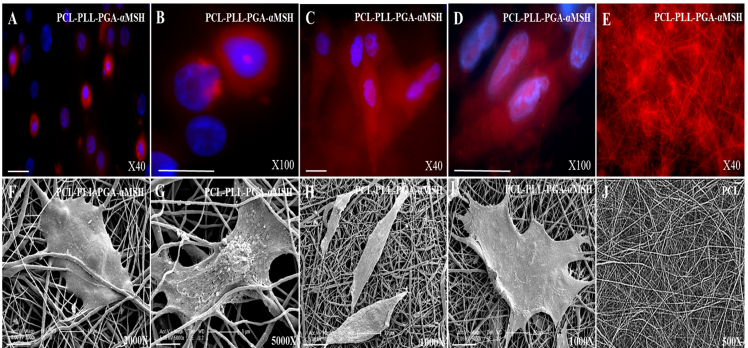
Figure 6. Immunofluorescent and Scanning Electron Micrograph (SEM). Analysis of oral epithelial cells ( A , B , F , G ), and human oral fibroblasts ( C , D , H , I ) on poly ‐ε‐ caprolactone (PCL) membrane functionalized by PLL ‐ PGA ‐α‐ MSH after 24 h. PCL membrane is used as the control ( E , J ). PLL ‐ PGA ‐α‐ MSH is conjugated to rhodamine Red. Blue pseudocolor = DAPI (fluorescent DNA dye). All the images